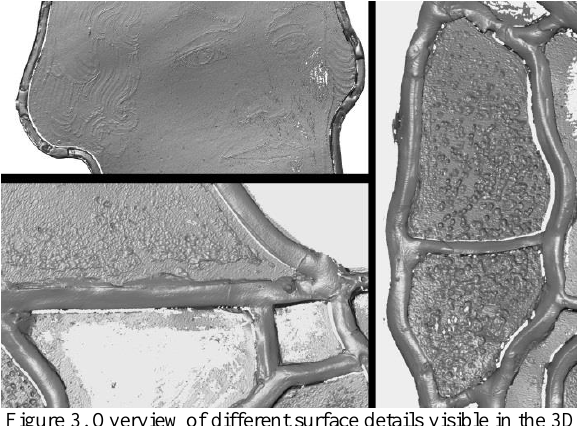
Figure 3. Overview of different surface details visible in the 3D scan; top left: ‘Schwarzlot’ painting of a face; bottom left: dust and dirt layers on the glass surface, next to clean glass panes; right: strongly corroded glass pane with a repair lead rod in the middle.